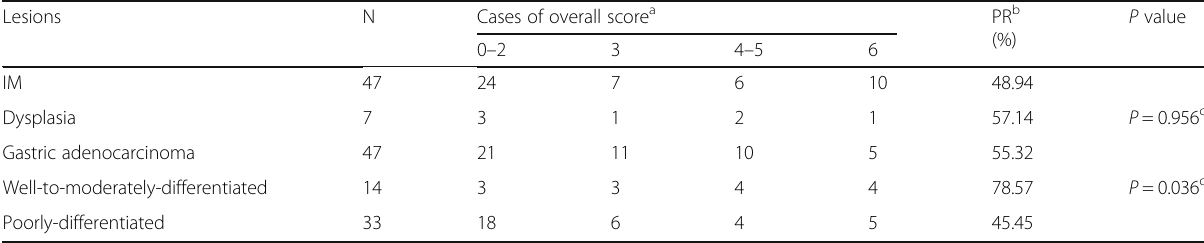
Table 2 GCRG213p expression in intestinal metaplasia (IM), dysplasia and gastric adenocarcinoma Lesions N Cases of overall score